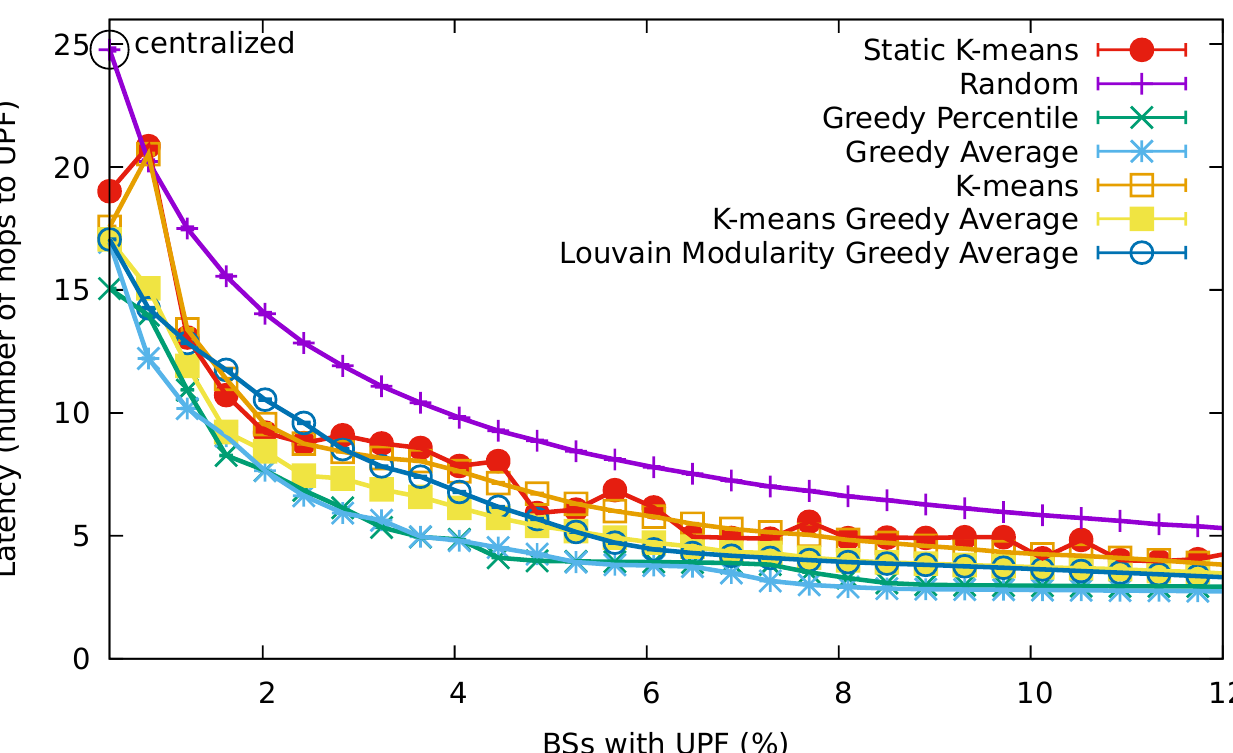
Figure 4. The 90th-percentile of the latency (number of hops) perceived by the UEs for a growing percentage of base stations containing a